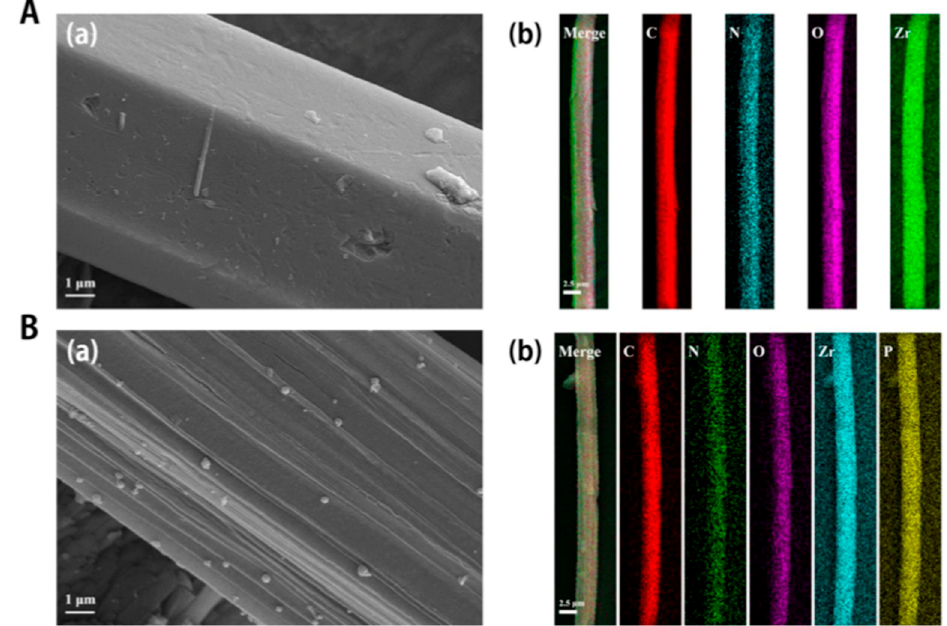
Figure 4. SEM images ( A ( a ) and B ( a )) and EDS mapping analysis ( A ( b ) and B ( b ))) of PCN-222 ( A ( a ) and A ( b )) and of PCN-222 adsorbed with FAM-aptamer ( B ( a ) and B ( b )), with the presence of P characteristic for the homogeneous adsorption of the aptamer. Adapted with permission from [46].